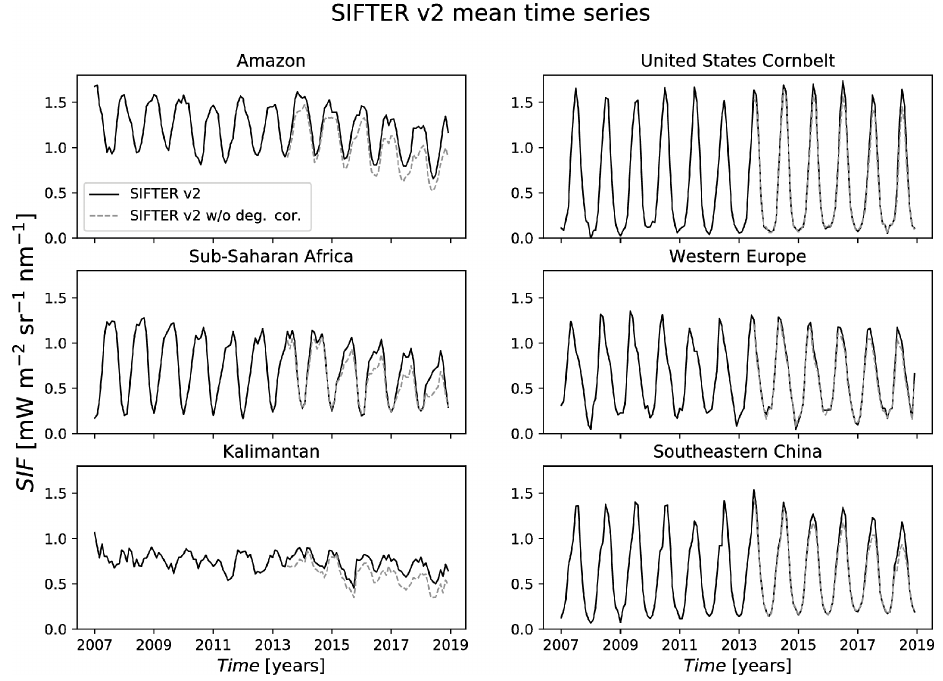
Figure 10. Time series of GOME-2A SIF retrieved with the SIFTER v2 algorithm with (solid black line) and without degradation correction (dashed grey line) over the six vegetated areas defined in Table 5. The degradation correction in our SIFTER v2 dataset is only applied for retrievals based on level-1 data retrieved from version 6.0, 6.1, and 6.2, i.e. from June 2014